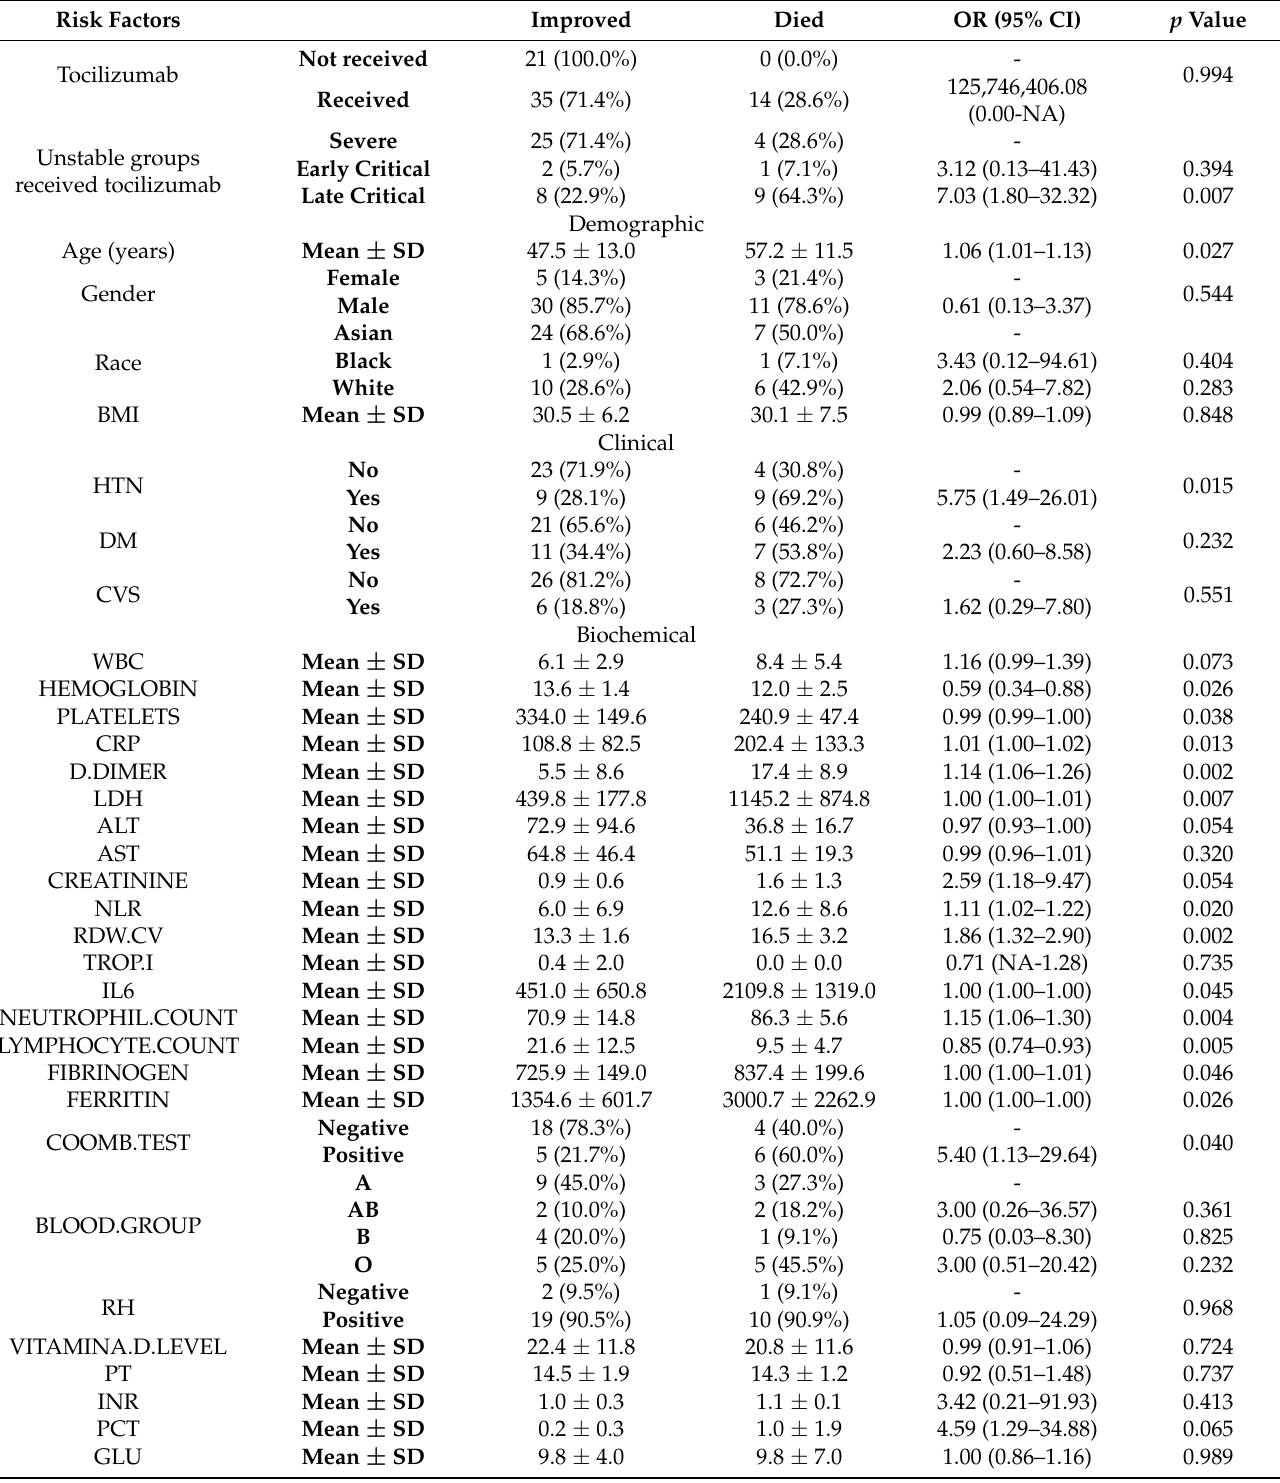
Table 2. Logistic regression models of the association of the demographic, clinical, and biochemical characteristics in the subgroups received tocilizumab (Unstable Severe–Early Critical–Late Critical) with COVID-19 outcome